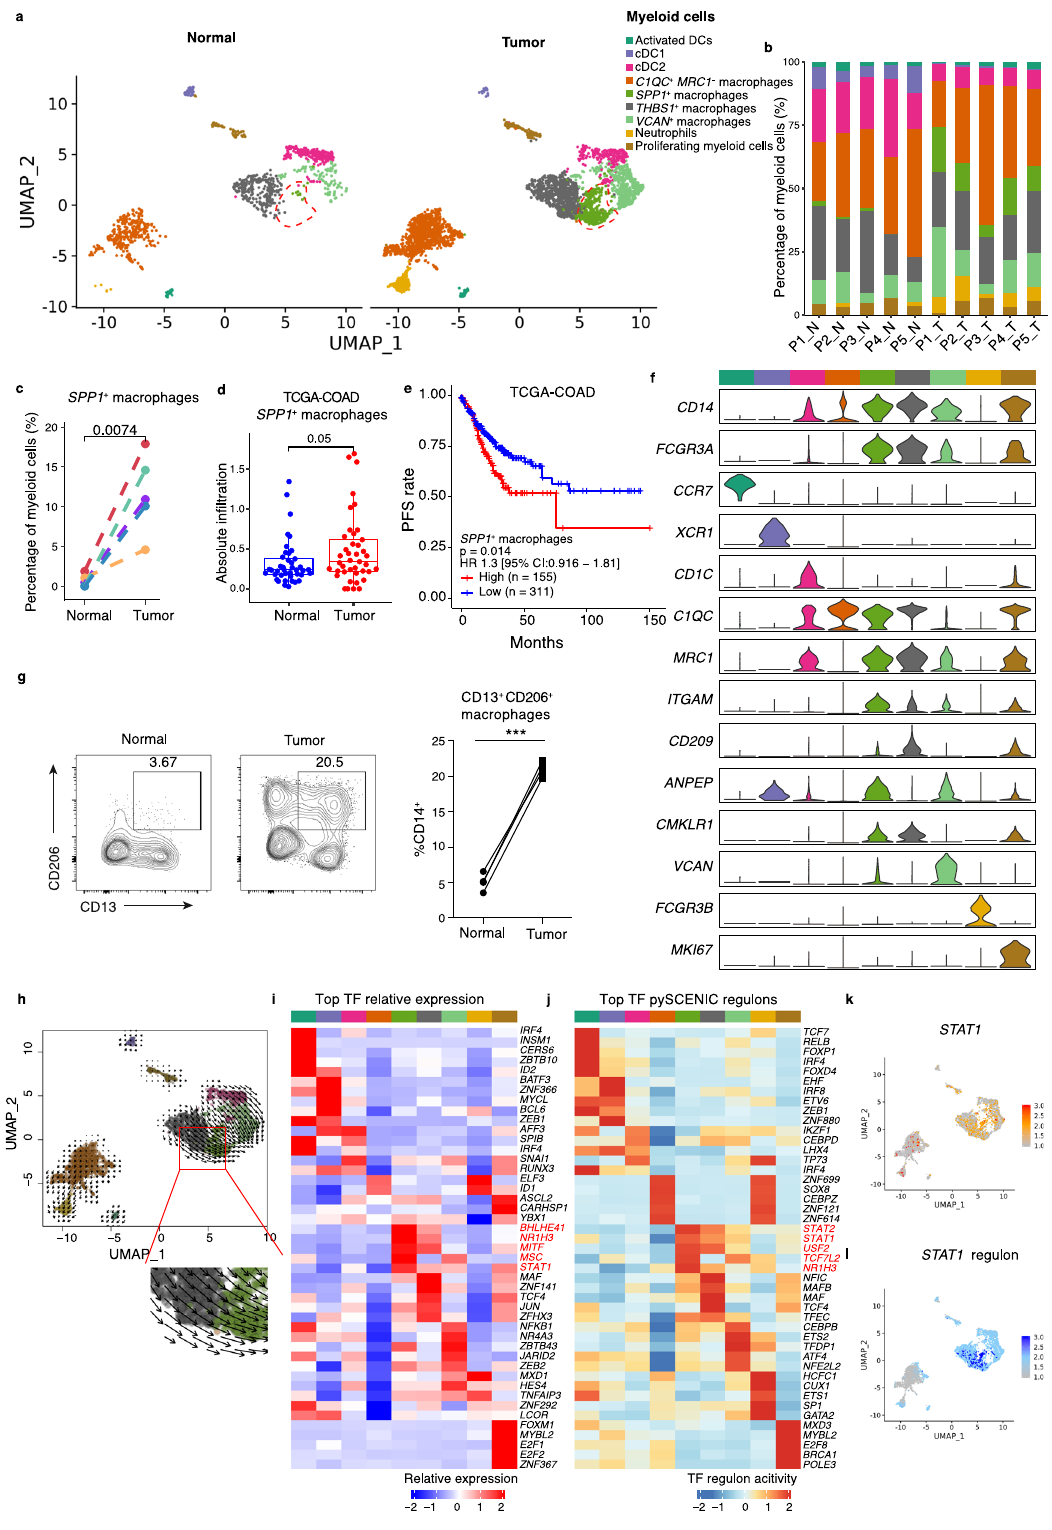
STAT1 , encoding master transcription factor that skews macro- phages toward an M1 phenotype in the mouse, was highly active in SPP1 + macrophages 60 (Fig. 4i – l). Genes highly expressed in SPP1 + macrophages were those involved in ECM − receptor interactions, the PPAR signaling pathway, and glycolysis/ gluconeogenesis (Supplementary Fig. 6i). Interestingly, SPP1 + macrophages were also potentially regulated by the HIF-1